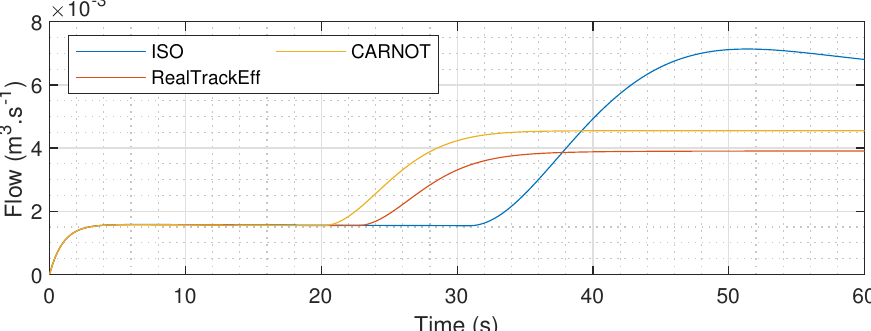
Figure 11. Flow of the HTF on the 8 August 2019 for the PID